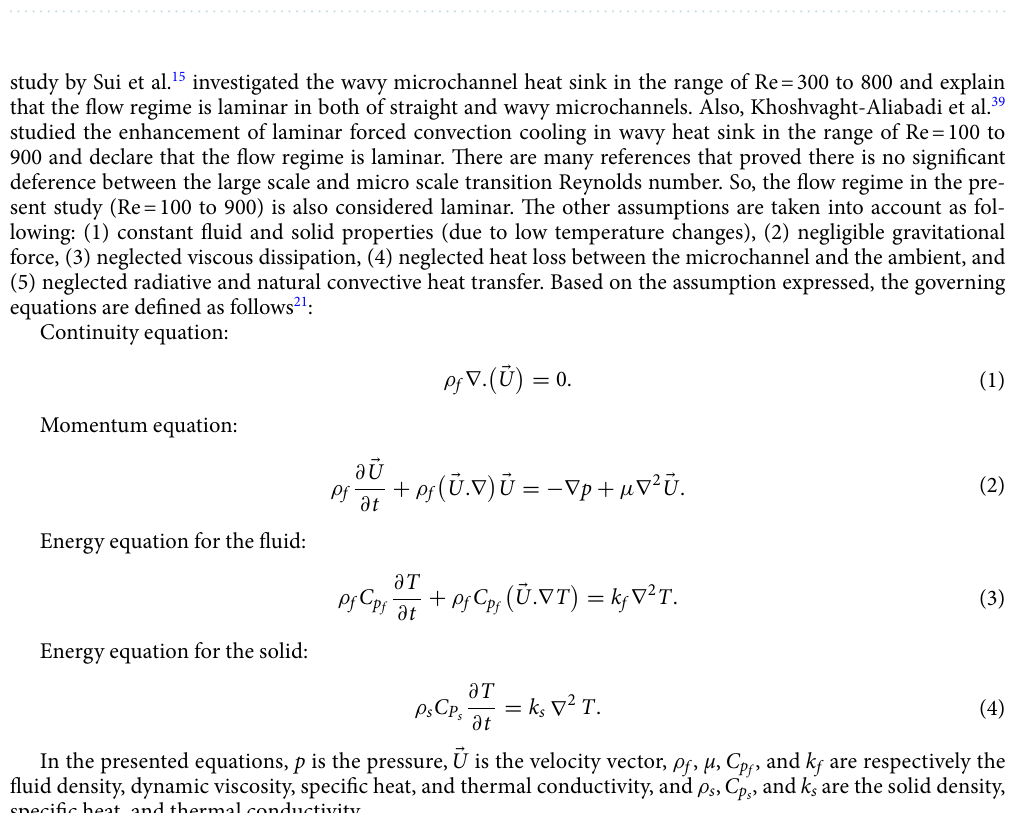
Table 3. Thermophysical properties of the working fluid and substrate material 37